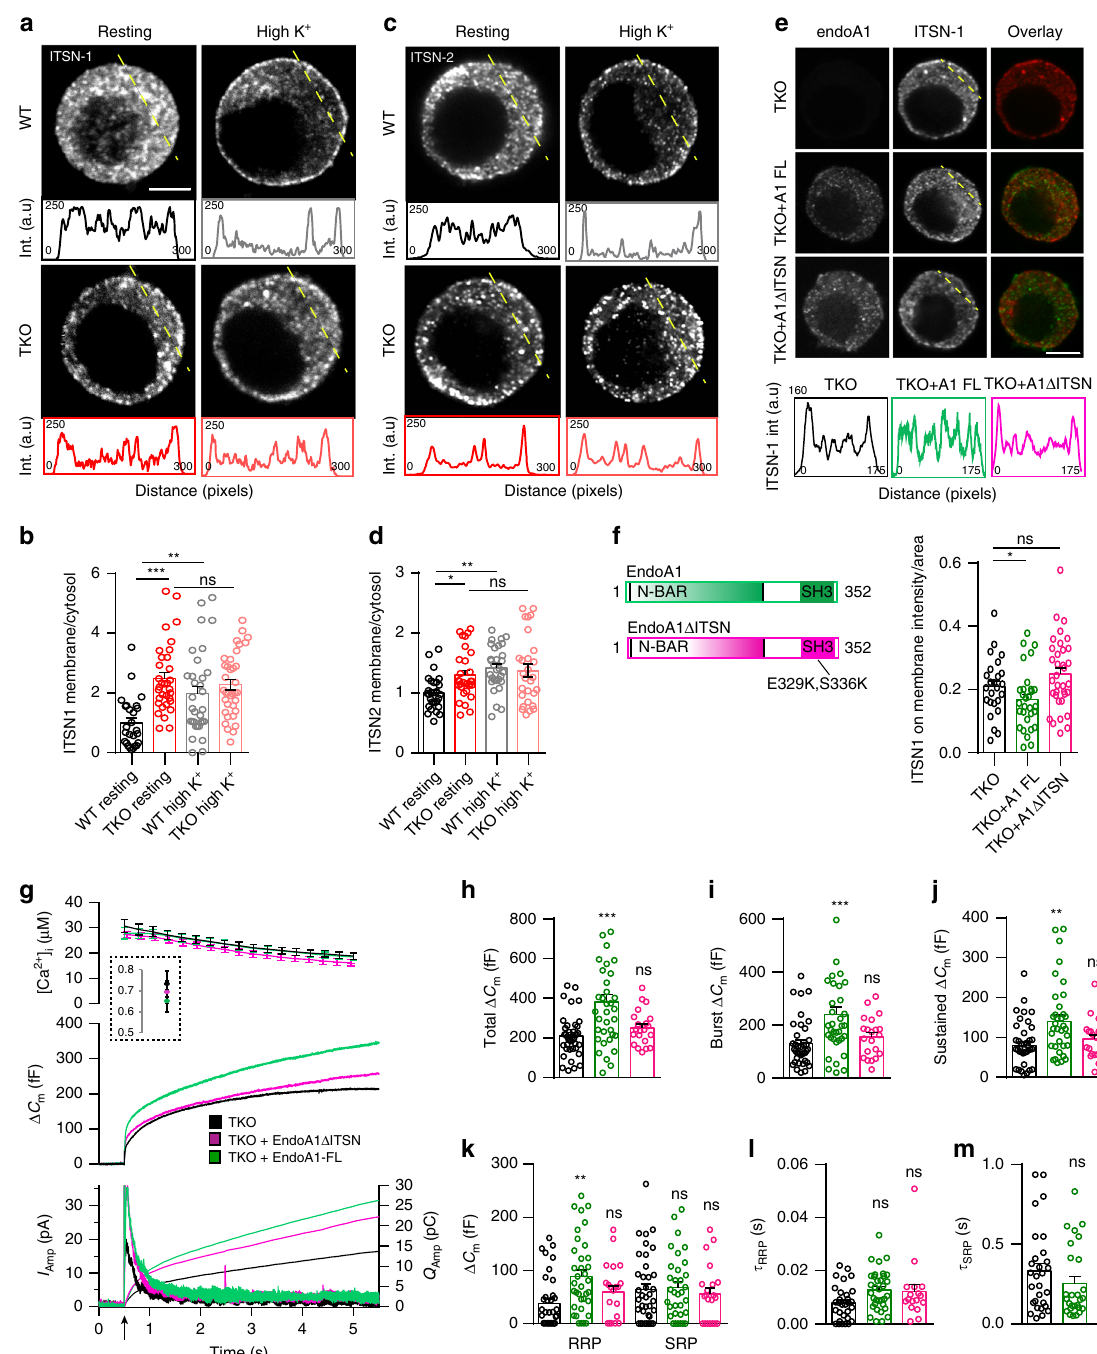
Fig. 7 Endophilin ’ s role in exocytosis is mediated, at least in part, through its interaction with intersectin-1. a – d Distribution of ITSN-1 and ITSN-2 was altered in the endophilin TKO cells. Representative confocal images of chromaf fi n cells stained for ITSN-1 ( a ) and ITSN-2 ( c ) under resting and stimulated (depolarization by high K + ) conditions (note that different cells are shown for each condition in the panel). Intensity line pro fi les below indicate ITSN-1 and ITSN-2 intensities along the line (the approx. line position is marked in yellow in a and c ). Quanti fi cation of ITSN-1 ( b ) and ITSN-2 ( d ) intensities in the cytosol vs. near the membrane (see Methods and Suppl. Fig. 7) revealed an altered distribution of ITSN-1 and ITSN-2 in endophilin TKO cells that did not further change upon stimulation. ITSN-1 ( N = 3, 3 mice each, WT resting (26 cells), TKO resting (33 cells), WT high K (32 cells) and TKO high K (36 cells), and ITSN2 ( N = 3, 3 mice/condition, WT resting (29 cells), TKO resting (30 cells), WT high K (30 cells) and TKO high K (28 cells). b , d note that WT resting vs. WT high K + , WT resting vs. TKO resting and TKO resting vs. TKO high K + were compared). e , f The altered distribution of ITSN-1 in endophilin TKO cells was rescued by expression of endophilin 1 (green traces), but not by expression of endophilin 1- Δ ITSN (endophilin E329K + S336K mutant that does not bind ITSN-1) (pink traces). N = 3, 3 mice, TKO (25 cells), TKO + A1FL (30 cells) and TKO + A1 Δ ITSN (35 cells). g – m Expression of endophilin 1 in endophilin TKO cells rescued exocytosis as inspected by combined capacitance and amperometry measurements (see Fig. 2), but the same effect could not be achieved by expressing an endophilin mutant that does not bind ITSN1 (E329K + S336K). Data shown in g – m are from four independent experiments, four mice each condition, cells TKO (39), TKO + A1-FL (36), and TKO + A1 Δ ITSN (21). Scale bars 3 µ m. Error bars denote SEM. N = number of independent replicates. One-way ANOVA with Tukey ’ s post-hoc test, * p < 0.05, ** p < 0.01; *** p < 0.001, ns not signi fi